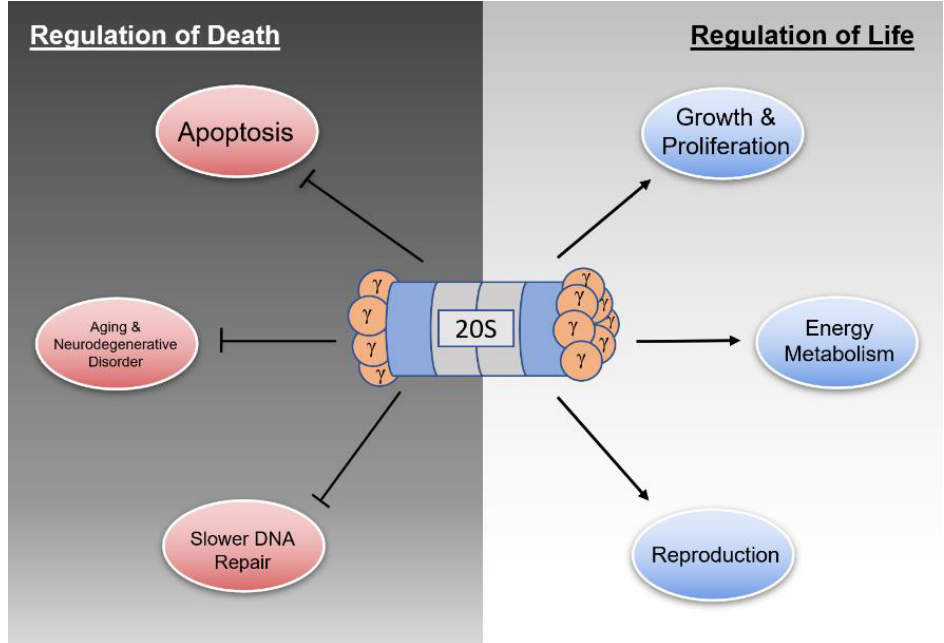
Figure 2. Regulatory functions of the REGγ -proteasome. Under normal expression conditions, REGγ maintains homeostasis via maintenance of processes listed under Regulation of Life and downregulation of processes listed under Regulation of Death.